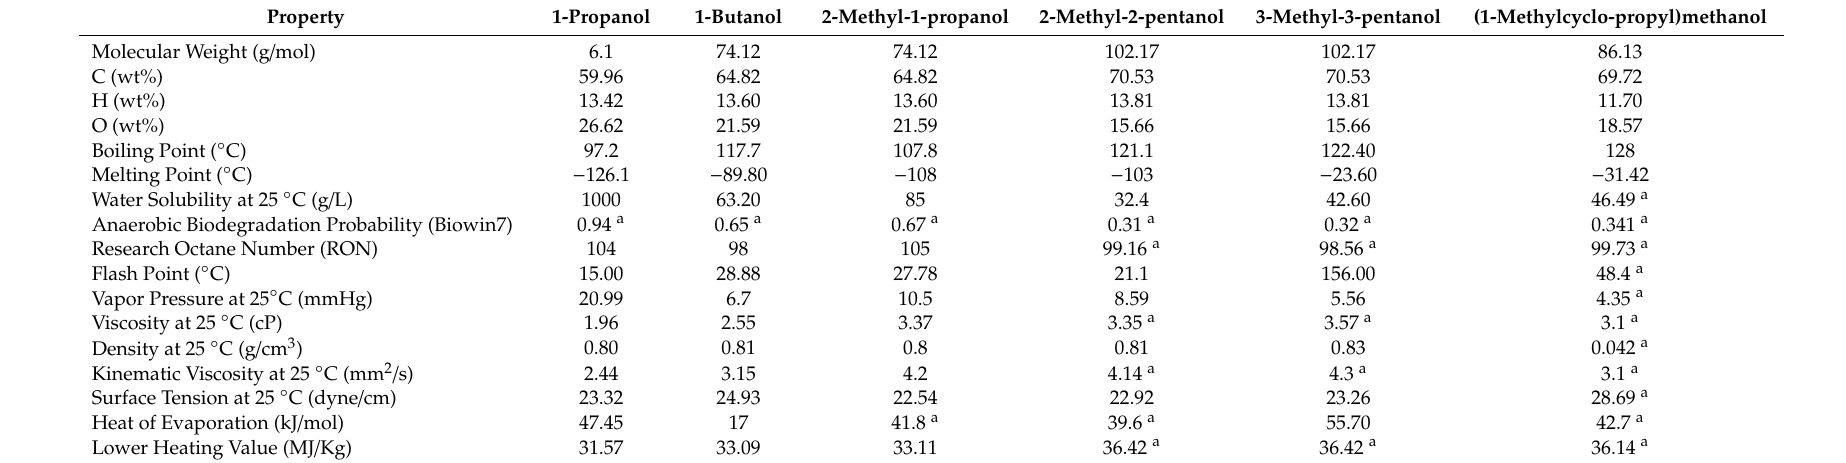
Table 4. Characteristics of six alcohols identified for high-level blending with gasoline (Scenario